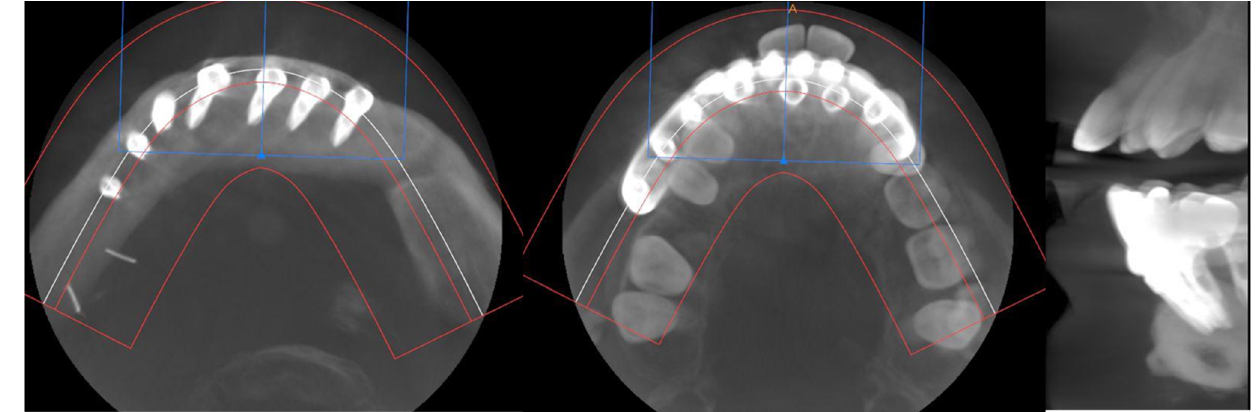
Figure 14. CBCT performed in the follow-up to evaluate bone resorption before and after implant loading.